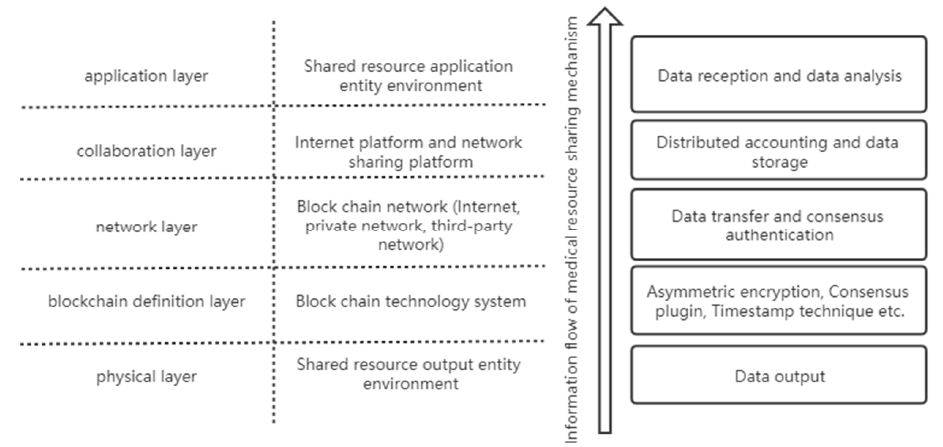
Figure 6. Information flow model.